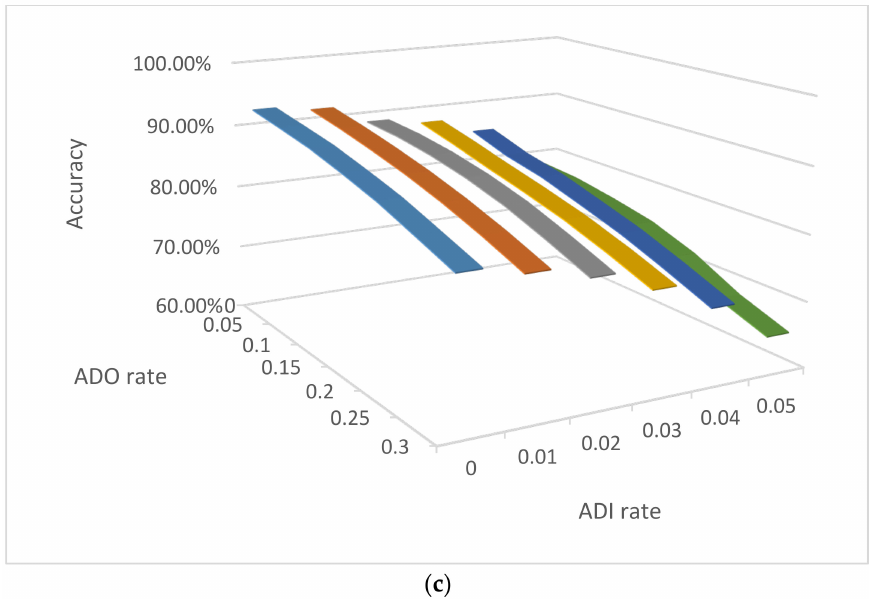
Figure 6. The accuracies of consensus for 3-person mixtures with 2, 6, and 12 single cells with various ADO and ADI rates in three scenarios: ( a ) diploid cells with three unrelated contributors, ( b ) diploid cells with three family trio contributors (father, mother, and child), and ( c ) haploid cells with three unrelated